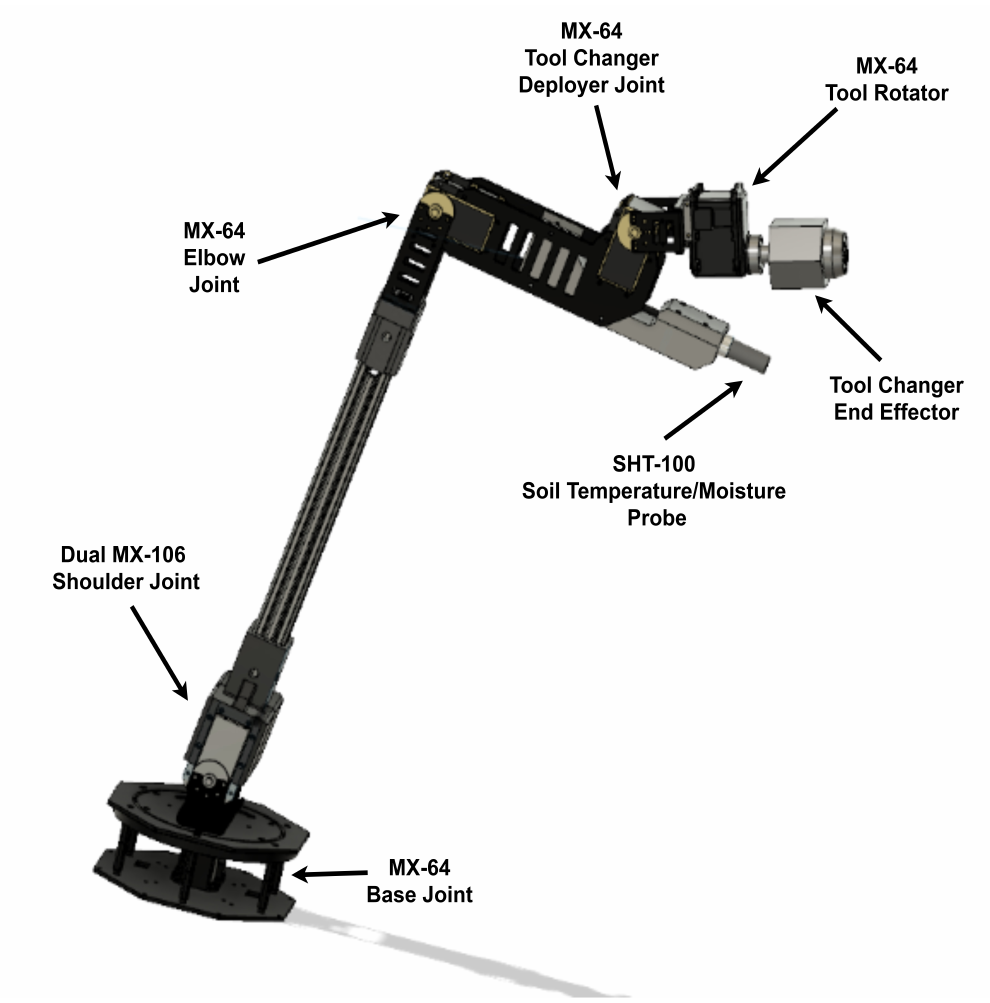
Figure 7. CAD model of the